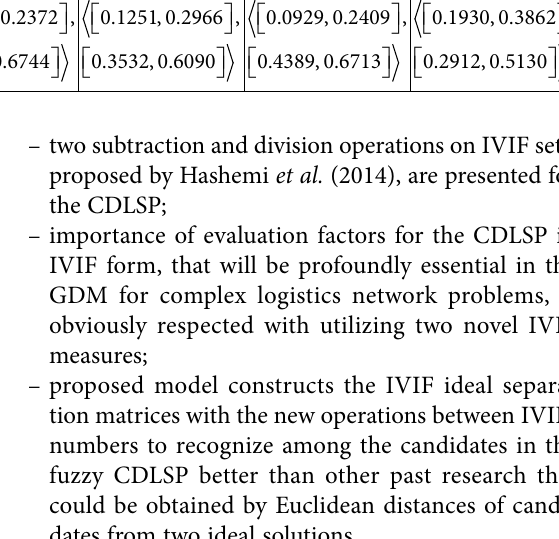
Evaluation factors